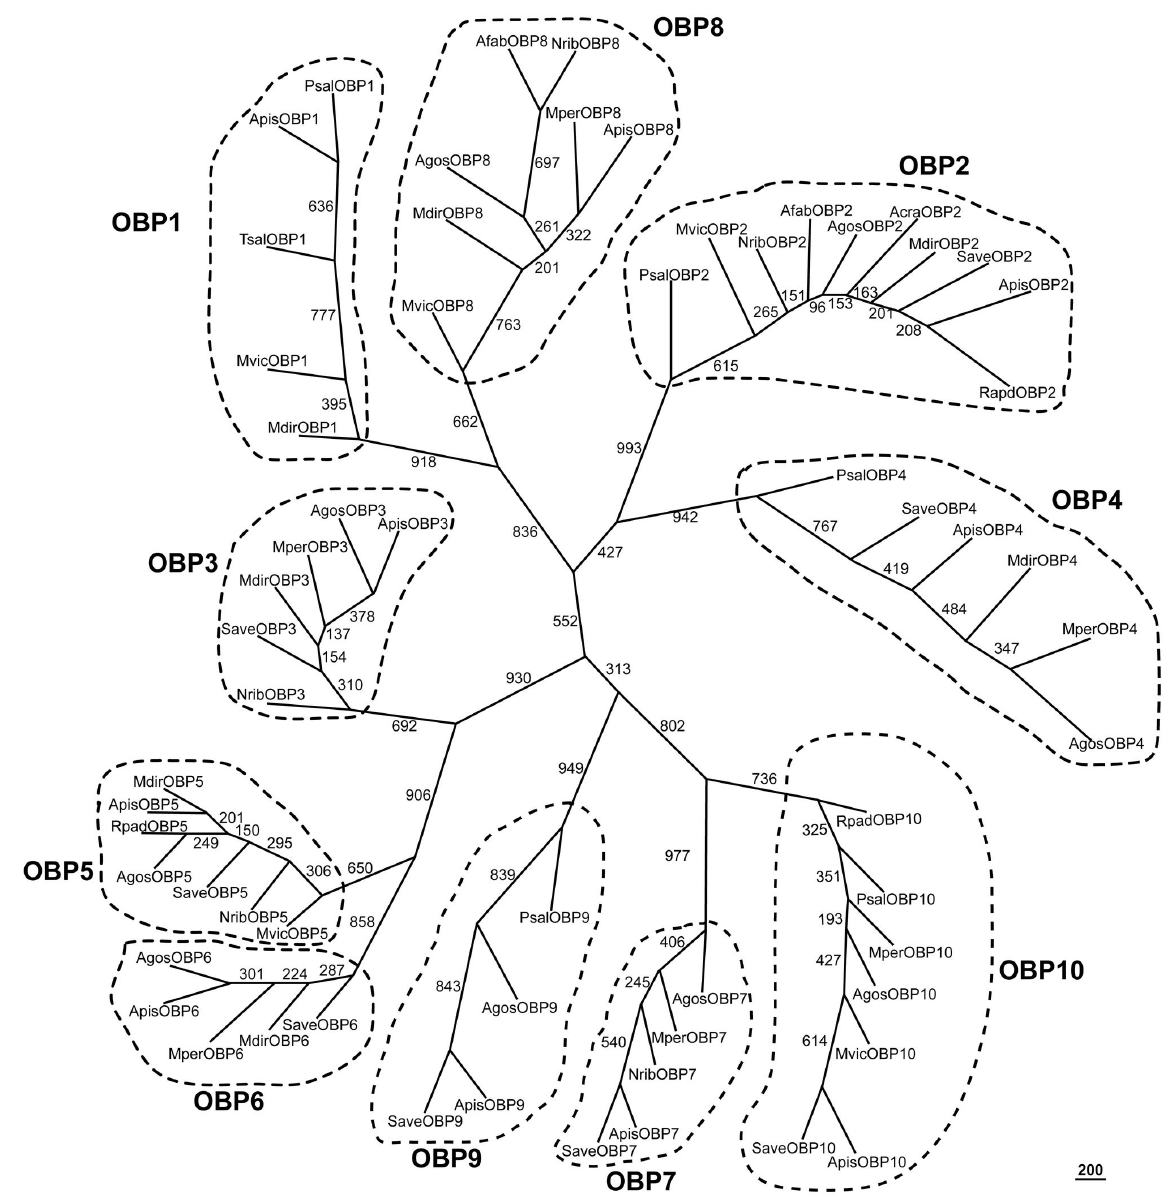
Figure 2. Phylogenetic tree of 62 OBPs from 12 aphid species. Numbers on branches show values of 1000 times replication bootstrap analysis and the bootstrap values are listed at each node. Accession numbers of the 62 aphid OBPs are as follow: Agos, Aphis gossypii . The accession numbers of AgosOBP2-10 are listed in Table 1. Psal, Pterocomma salicis (PsalOBP1: